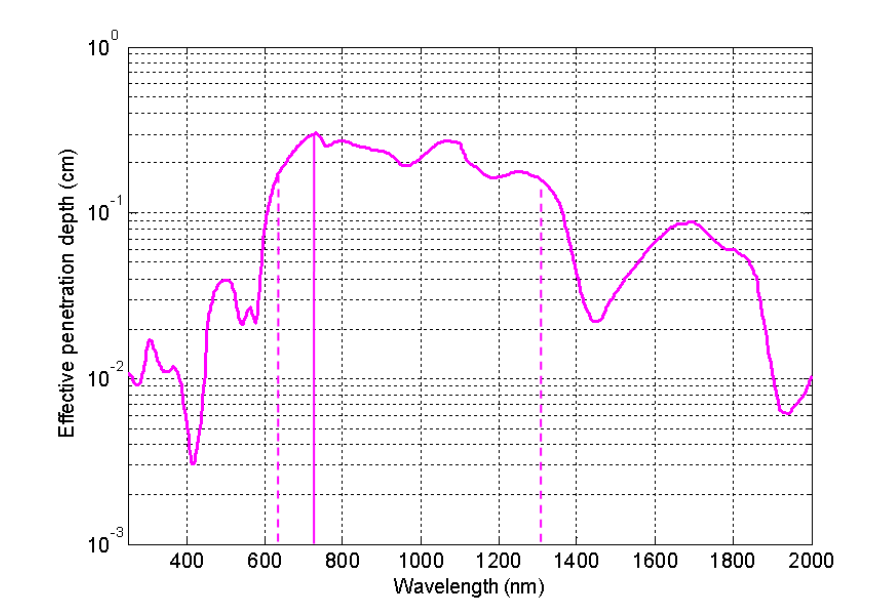
Figure 4. Effective penetration depth in tissue Near-infrared window in biological tissue (626–1316